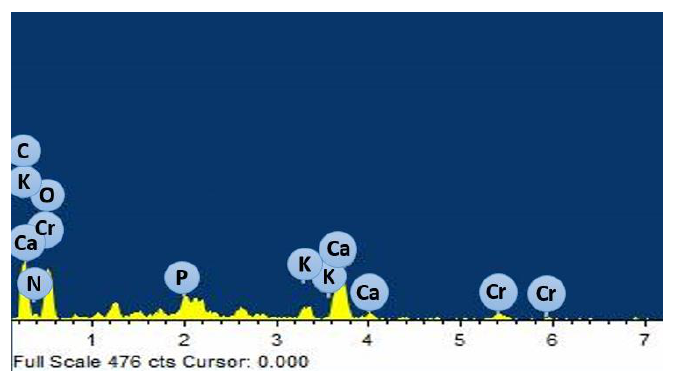
Figure 4. Energy dispersive x-ray spectroscopy graph of formulated organic